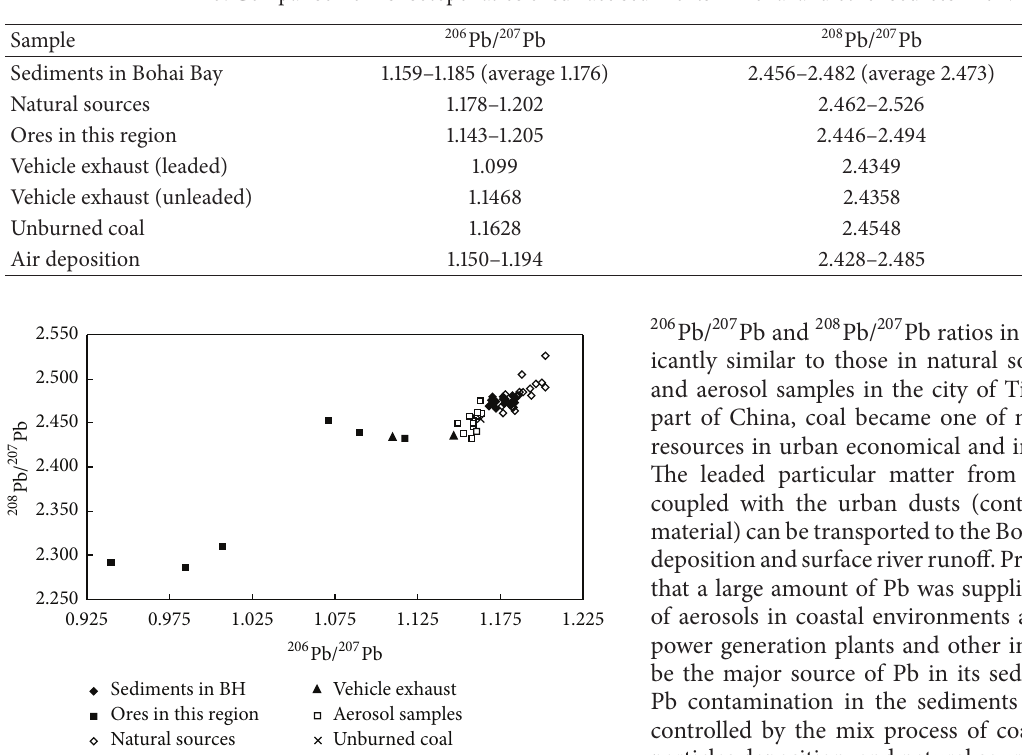
Table 3: Comparison of Pb isotope ratios of surface sediments in Bohai and other sources in environment.